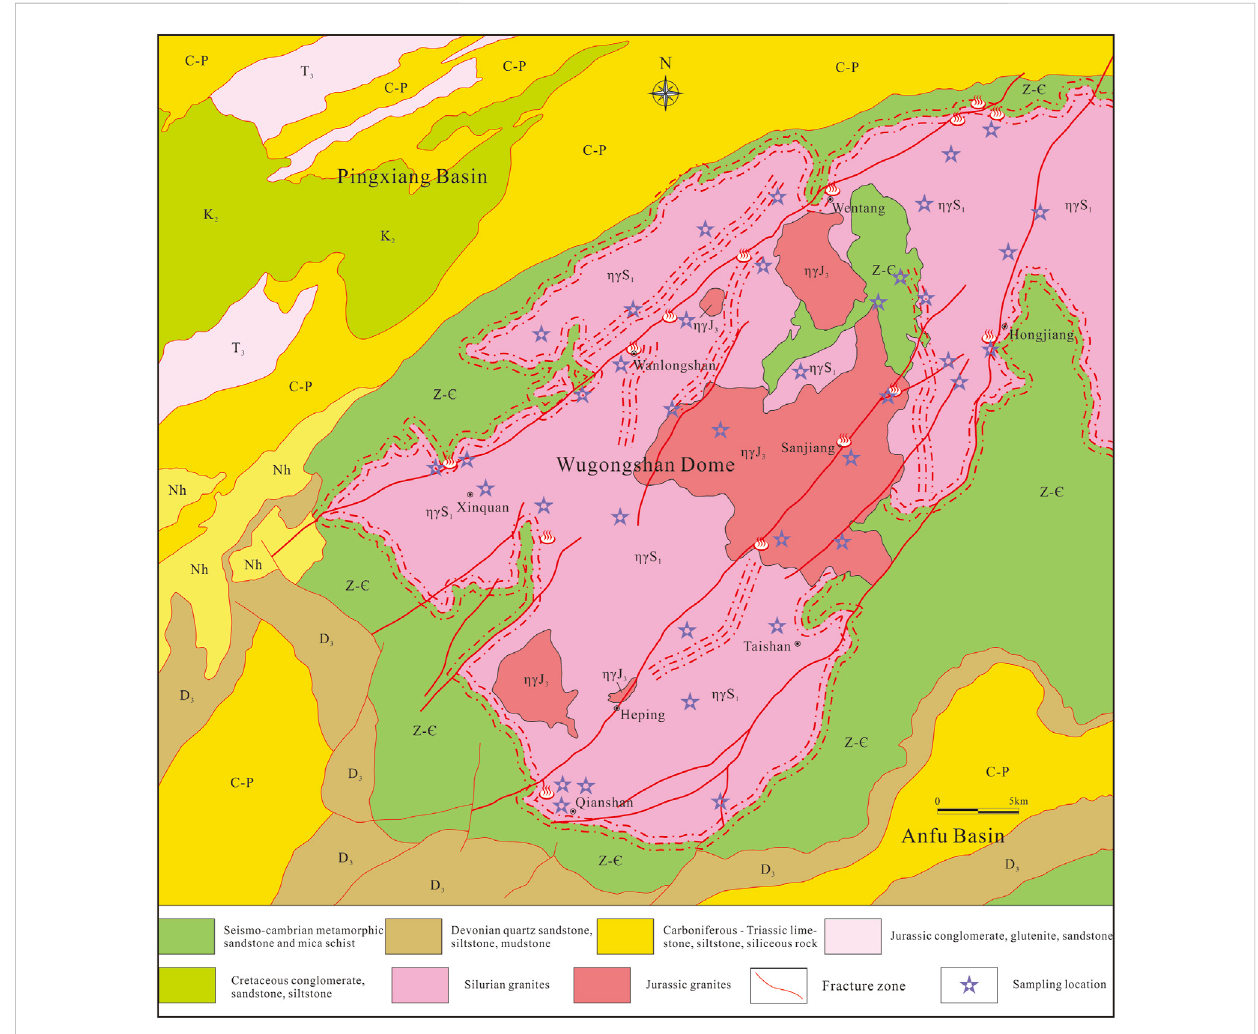
FIGURE 2 Geothermal geological map of the Wugongshan area (modi fi ed from Shu et al.,